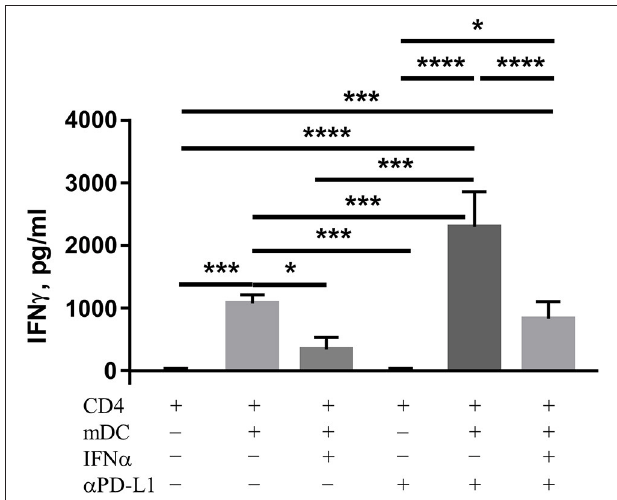
FIGURE 5 | PD-L1 controls IFN γ release from CD4T cells stimulated by DC. Allogeneic CD4 cells were isolated and cocultured with DC in the presence or the absence of anti-PD-L1 blocking antibody or vehicle control. The level of IFN γ in supernatants was determined by Luminex assay. The results are presented as column bar graphs and statistically analyzed using ordinary one-way ANOVA with the Tukey’s multiple comparisons post-test, n = 3–6, * p < 0.05, *** p < 0.001, and **** p <